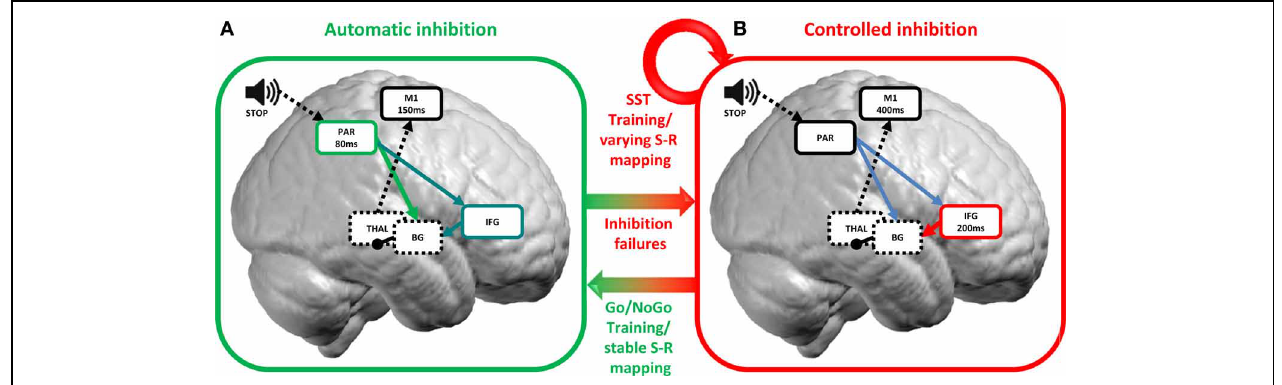
FIGURE 1 | Two mechanisms of training-induced plasticity of inhibitory control. Inhibition stimuli are conveyed to sensory areas processing stimuli features at ca. 80ms within parietal brain regions (Hyde et al., 2008; Spierer et al., 2008). (A) In conditions of stable S-R mapping, as for the Go/NoGo task, participants switch from a controlled to an automatic inhibition mode with training. Automatic inhibition develops in parietal areas at ca. 80ms and shortcuts top-down inputs from the IFG (green arrow; although see Lenartowicz et al., 2011 for evidence of a role for the IFG in automatic inhibition; blue arrows) in turn leading to faster inhibition (ca. 150ms; calculated as the mean RT − 100ms which corresponds to the latency of M1